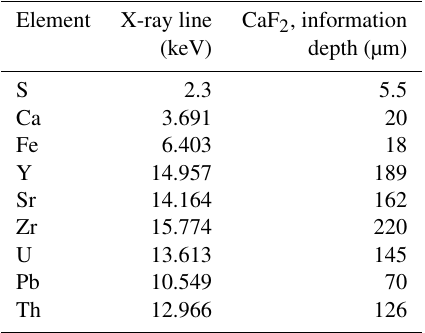
Table A3. Information depth estimation (µm) and measured X-ray line (keV) of the SR-XRF method in fluorite for each